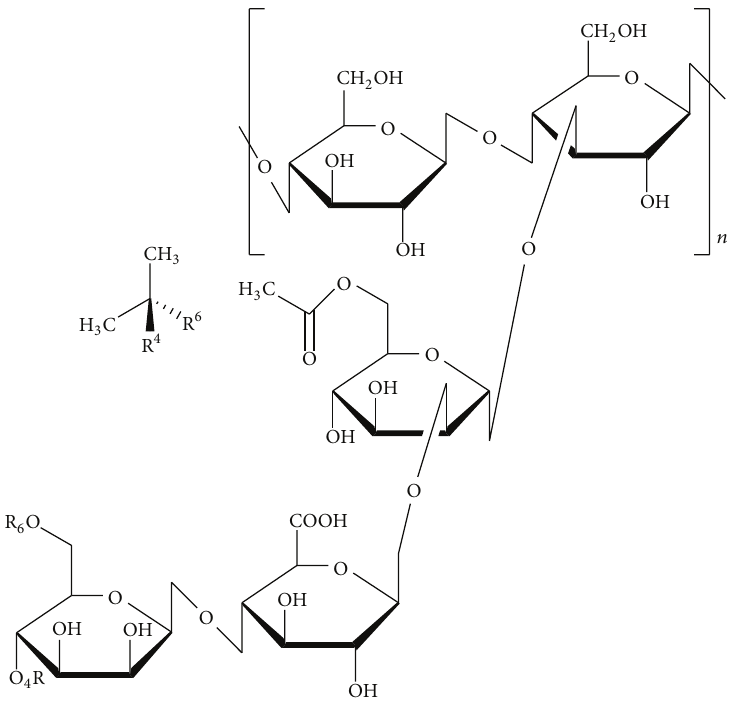
Figure 1: Primary structure of xanthan gum [14].